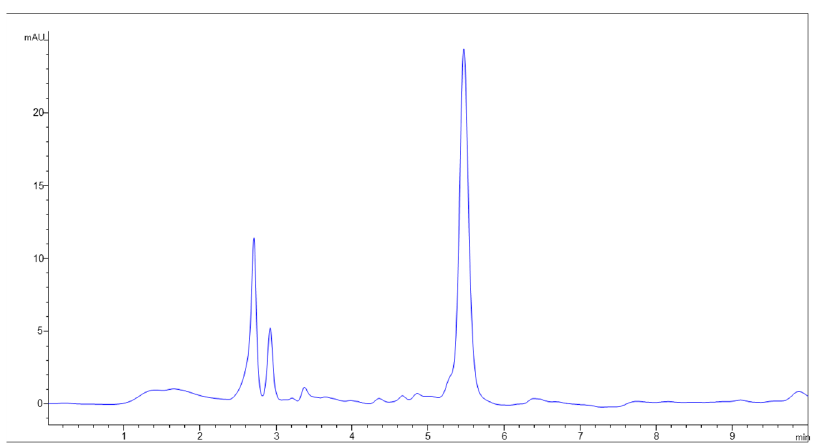
Figure 2. HPLC-UV/VIS chromatogram of vitamin C determined in smoothies. As can be seen, the total vitamin C results ranged between 491.78 and 2660.02 µg AA/ mL smoothie. These results were similar to those obtained by Müller et al. (2010), whose vitamin C values in commercial smoothies ranged 42–95 mg AA/100 mL smoothie [55]. Moreover, Hurtado et al., (2015) [59] reported values of ≈ 40 mg AA/100 mL of total vitamin C in smoothies composed of apples, oranges, strawberries and bananas. The smoothie that had the highest content of vitamin C was 9. It was the only one that presented carrots in its ingredients, and a significative ( p < 0.05) strong correlation with the content of AA (r = 0.8439) and total vitamin C (r = 0.9222) was found. After it, smoothies 18 and 10 also presented the highest values of vitamin C. The three smoothies had the presence of mango in their composition in common. In fact, a moderately strong positive correlation ( p < 0.05) was found between mango content and AA (r = 0.5658) and total vitamin C (r = 0.5447) content. In general, tropical fruits showed a positive correlation with ascorbic acid. Regarding the proportion of the AA and DHAA, it can be observed that AA was the majoritarian with a relation higher than 2:1 (AA: DHAA), except in some cases. There were some smoothies where all of the vitamin C content was in the form of AA, such as smoothie 1, 5, 6, and 18. Smoothie 4 had a very similar amount of AA and DHAA (relation 1.15) that could be due to the balance in its composition between apples and red fruits. In contrast, in smoothie 16, it was observed that the entire amount of total vitamin C was in the form of DHAA. This can be explained by the presence of a high amount of apple in combination with other minor ingredients such as cucumber, celery, kale and ginger, and no other fruits. Apple was the ingredient that showed a higher sig- nificant correlation ( p < 0.1) with the total dehydroascorbic acid content. 2.5. Antioxidant Activity of Smoothies by DPPH and FRAP Assays The antioxidant activity of the smoothies has been determined by two methods: DPPH and FRAP, and the results are shown in Table 5. Both methods showed a significant ( p < 0.05) positive strong correlation among them (r = 0.8908). Table 5. Antioxidant activities of the smoothies expressed as average ± standard deviation. Smoothie